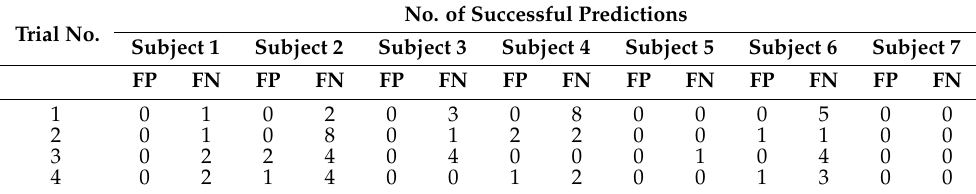
Table 13. Number of false positives (FP) and false negatives (FN): pinch. Trial No.